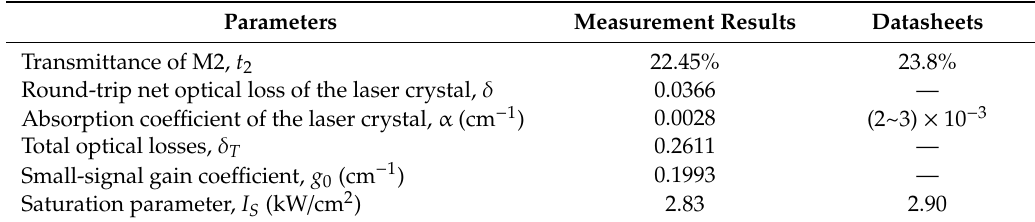
Table 1. Results of the measurement of internal parameters (calibrated δ i =